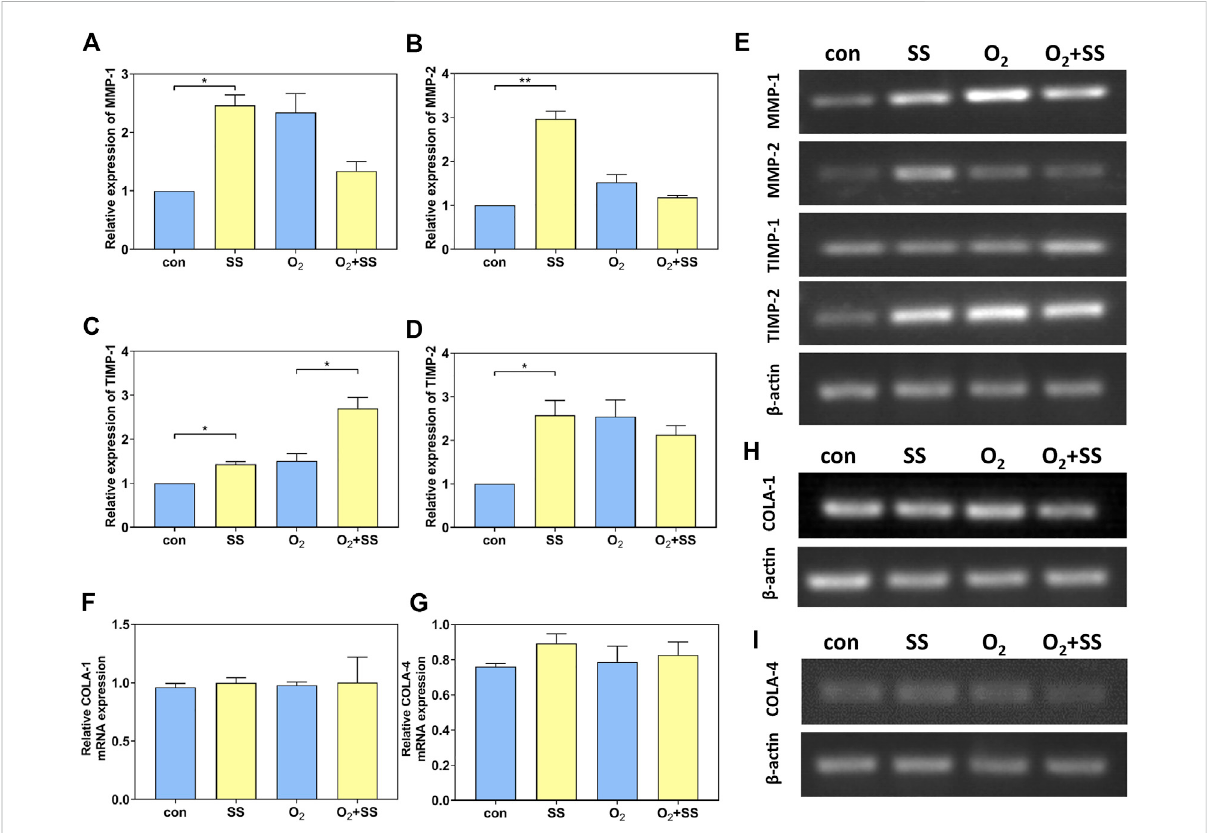
FIGURE 4 Effectofsenescenceonmatrixmetalloproteinases(MMP),tissueinhibitorsofmetalloproteinases(TIMP),andcollagenmRNAexpressionofPTM cells in response to shear stress. (A – E) PCR quanti fi cation of MMP-1, MMP-2, TIMP-1 and TIMP-2 mRNA expression of normal and senescent PTM cells under static conditions or subjected to shear stress (* p < 0.05, ** p < 0.01). (F, H) PCR quanti fi cation of collagen I (COLA-1) mRNA expression of normal and senescent PTM cells under static conditions or subjected to shear stress. (G, I) PCR quanti fi cation of collagen IV (COLA-4) mRNA expression of normal and senescent PTM cells under static conditions or subjected to shear stress. SS stands for shear